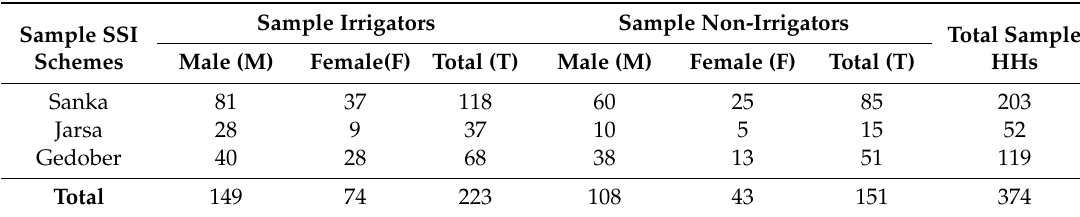
Table 1. Sample household heads taken from irrigators and